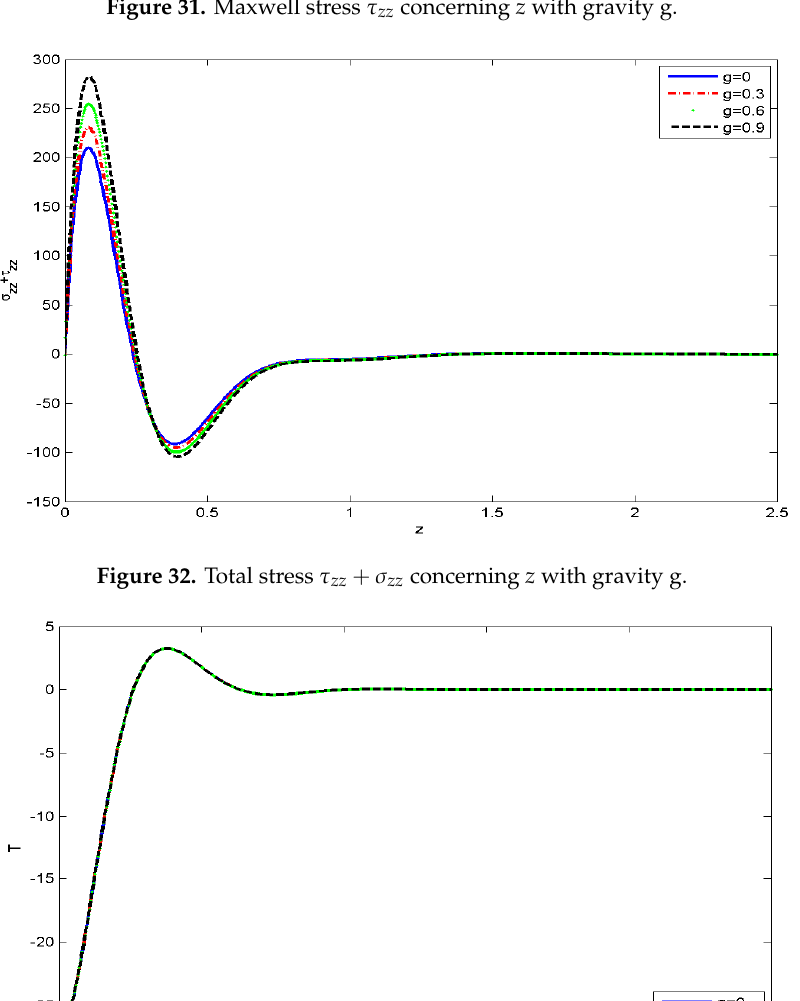
Figure 31. Maxwell stress τ zz concerning z with gravity g.